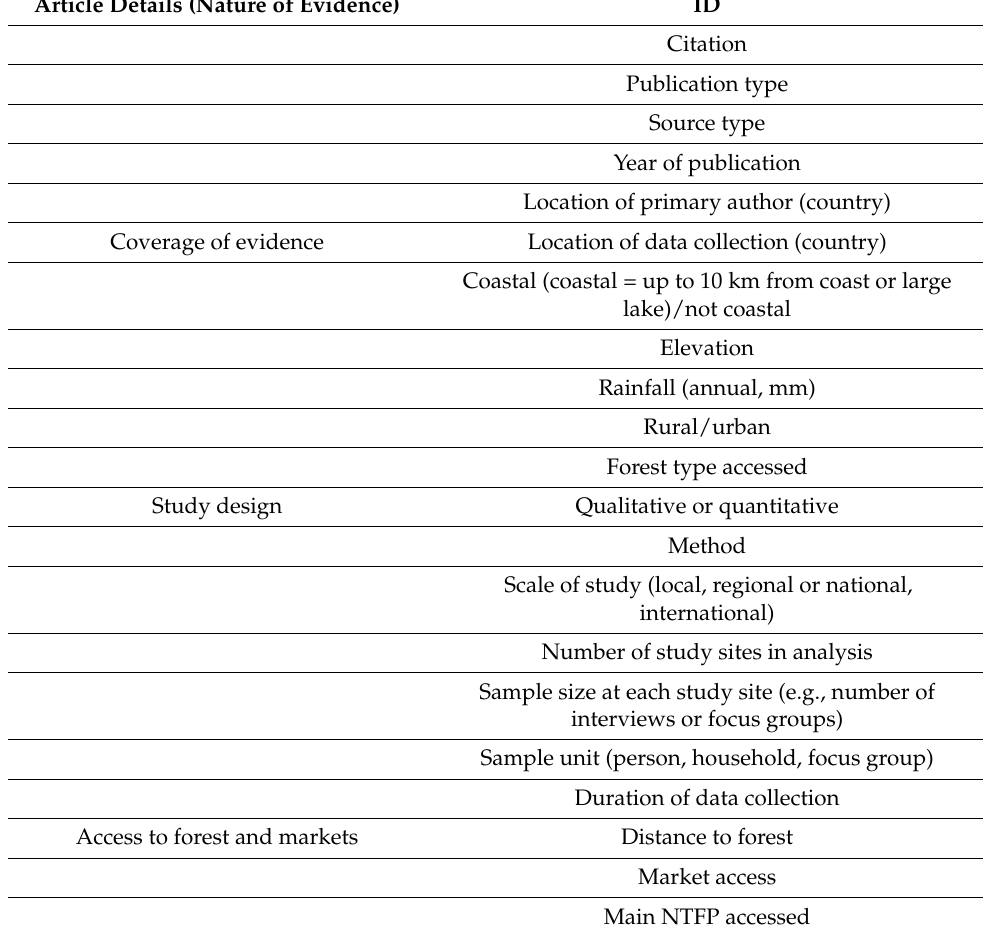
Table 3. Data coding and data extraction